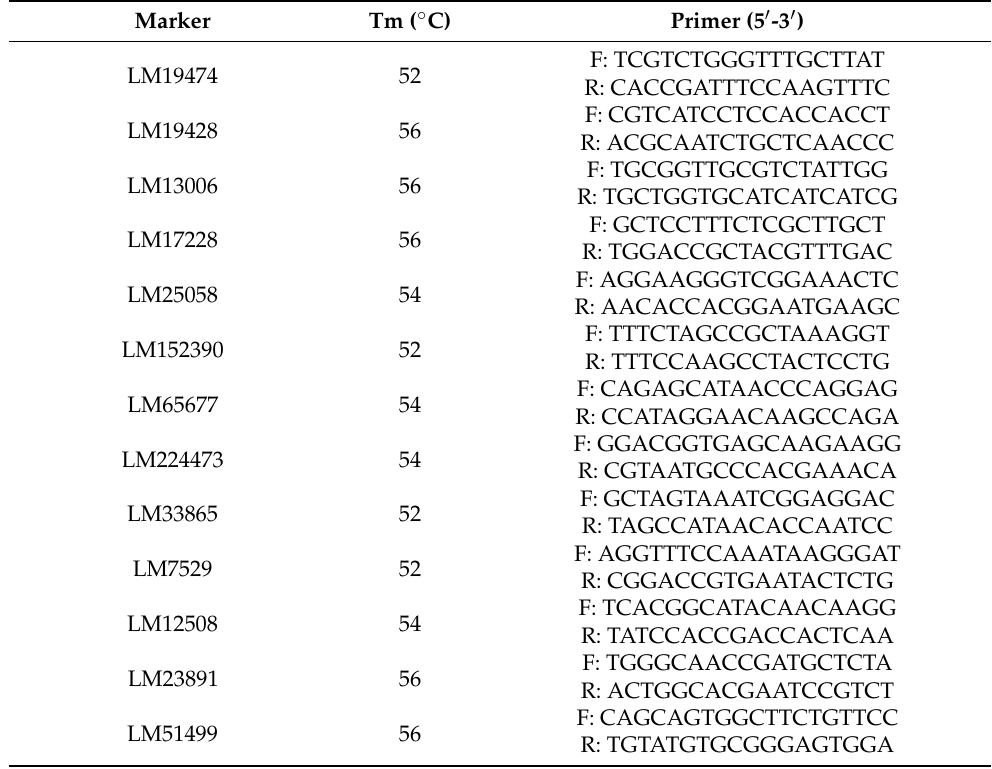
Figure 7. Molecular marker development and PCR amplification of wheat- Leymus mollis disomic substitution line 17DM48. The red arrows indicate the L. mollis specific bands. (M). DNA marker DL2000. ( 1 ) 7182. ( 2 ) D4286. ( 3 ) L. mollis . ( 4 ) 17DM48. ( a ) LM19474. ( b ) LM19428. ( c ) LM13006. ( d ) LM17228. ( e ) LM25058. ( f ) LM152390. ( g ) LM65677. ( h ) LM224473. ( i ) LM33865. Table 2. Specific molecular markers developed for 17DM48 based on SLAF-seq.